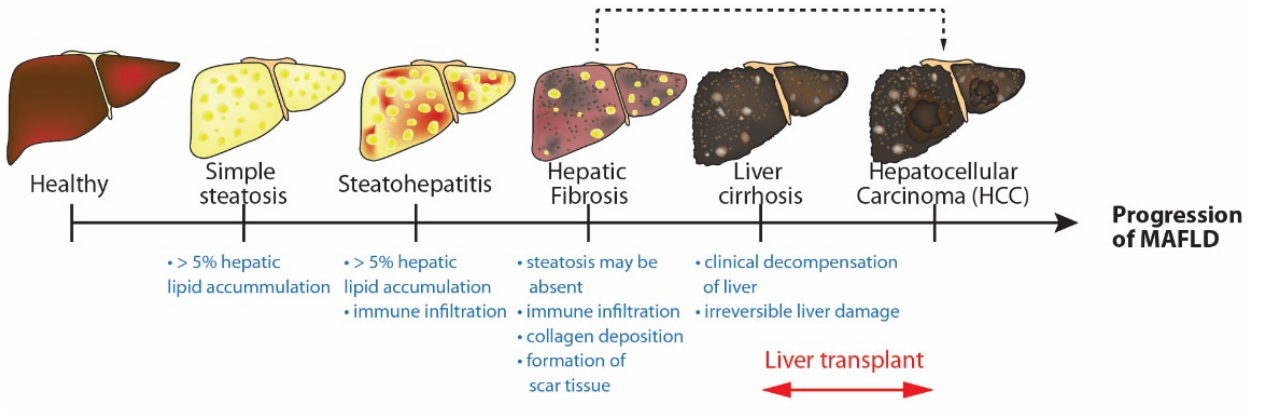
Figure 1. Progression of MAFLD (and